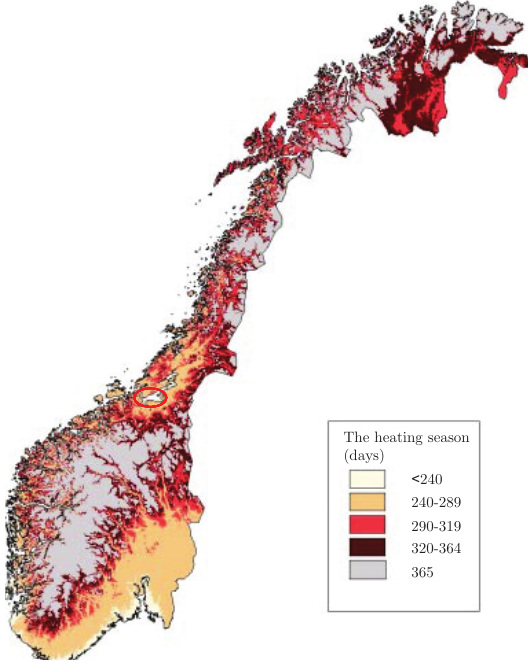
Figure 3: Heating season in Norway Tveito (2002) the specific date in the same period (years 2006-2014).